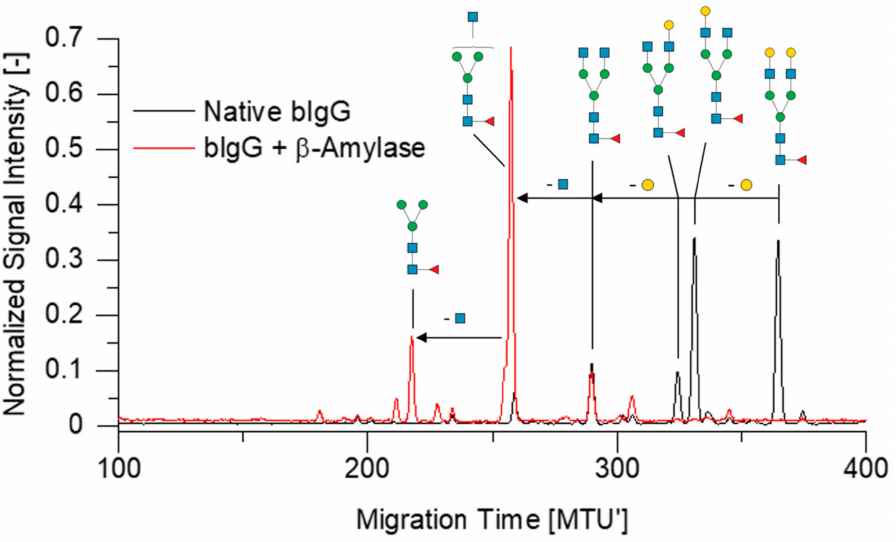
Figure 3. Overlay of xCGE-LIF generated fingerprints of bovine IgG (bIgG)-derived N -glycans before and after overnight treatment with β -amylase. β -galactosidase and N -acetylglucosaminidase side reactivity of β -amylase were revealed. Migration time plotted on the x -axis was aligned to an internal migration time standard, resulting in Migration Time Units (MTU’). Signal intensity (peak height) of automatically picked peaks was normalized to a sum value of 1. Annotation of N -glycan peaks is based on earlier reports [45]. Data analysis was performed using glyXtoolCE™. Symbolic representation of N -glycan structures follows the guidelines of Symbol Nomenclature for Glycans (SNFG)